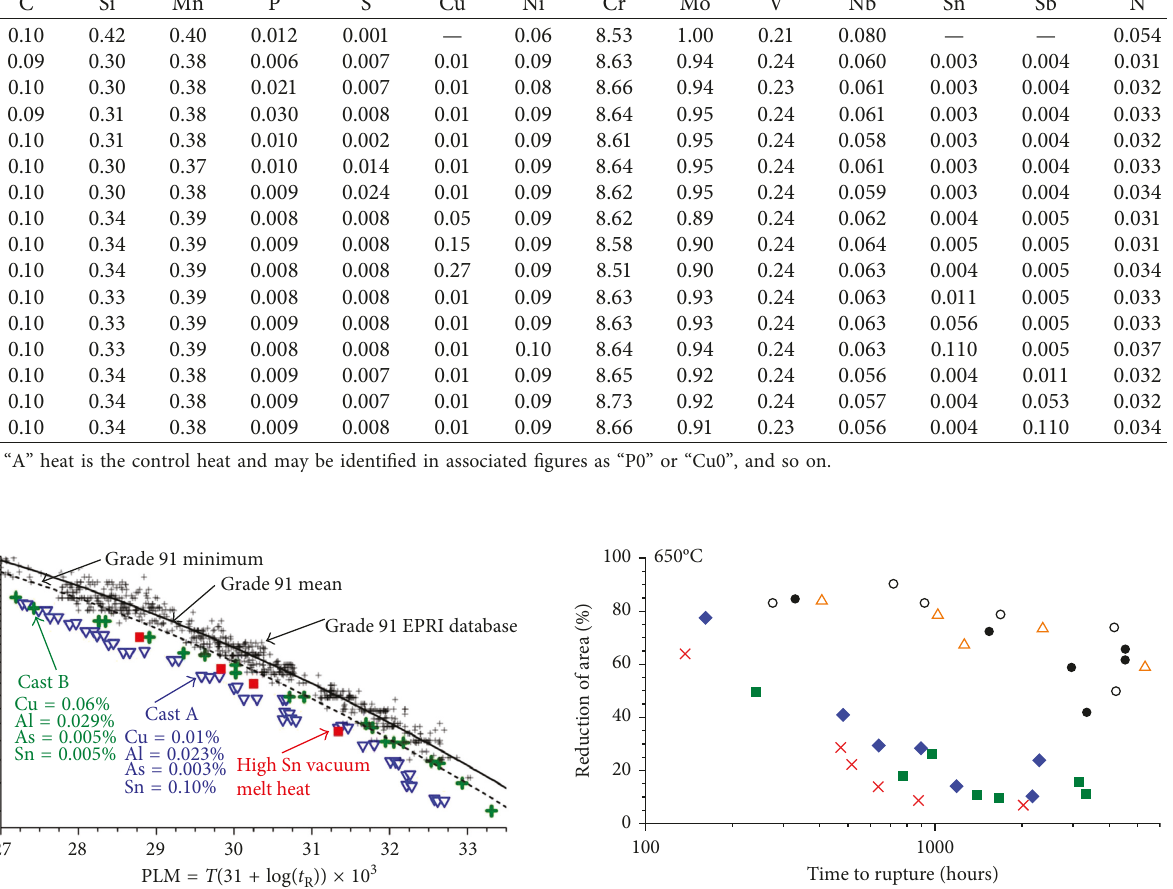
Table 2: Chemical composition of examined Grade 91 heats with controlled additions of impurity/tramp elements P, S, Cu, Sn, and Sb [27]. C